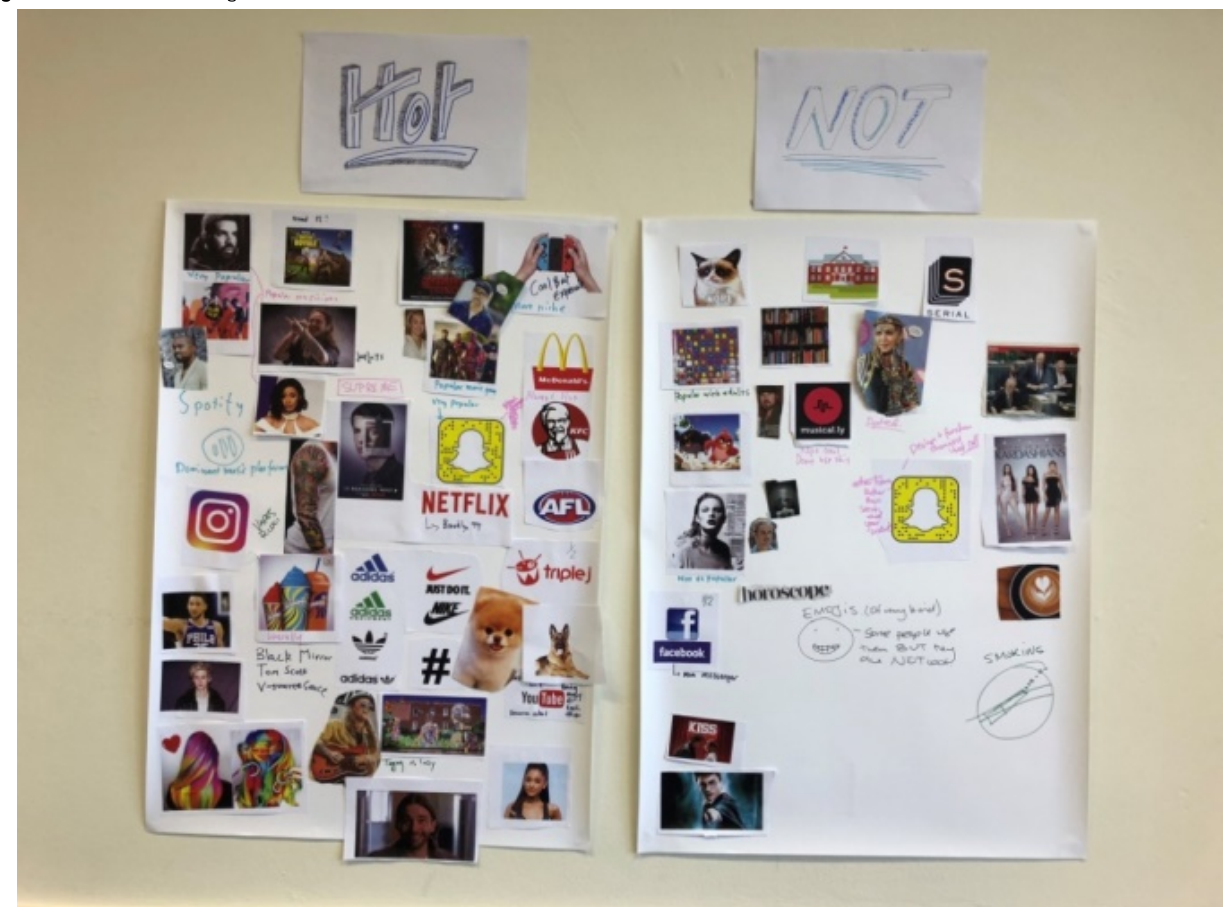
Figure 1. Hot or Not?